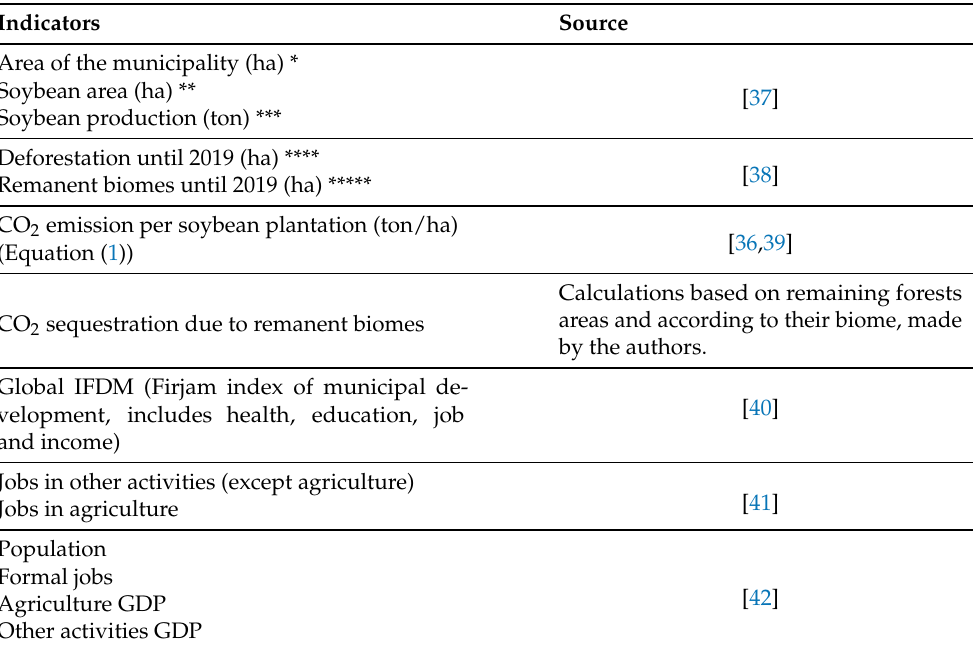
Table 1. Selected indicators to carry out the evaluation.